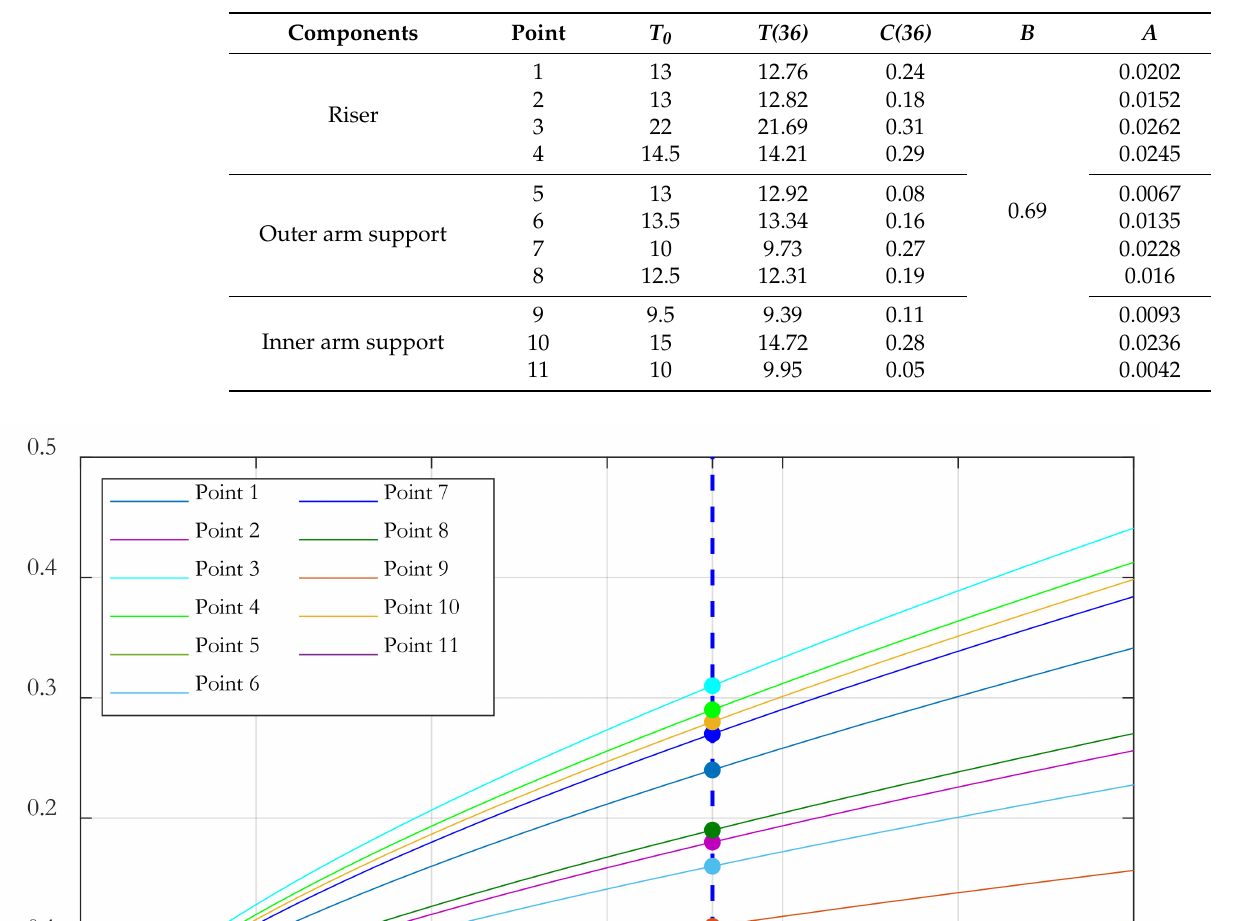
Table 13. Determining the A parameter.